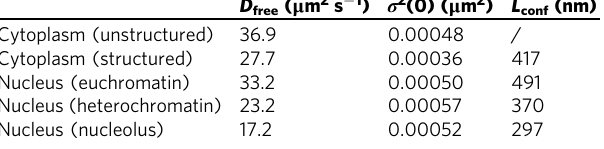
Table 1 Table of values obtained from the iMSD fi tting for free diffusion ( D free ) and con fi ned diffusion ( L conf ) for each compartment, along with the intercept value in τ = 0 ( σ 2 (0))